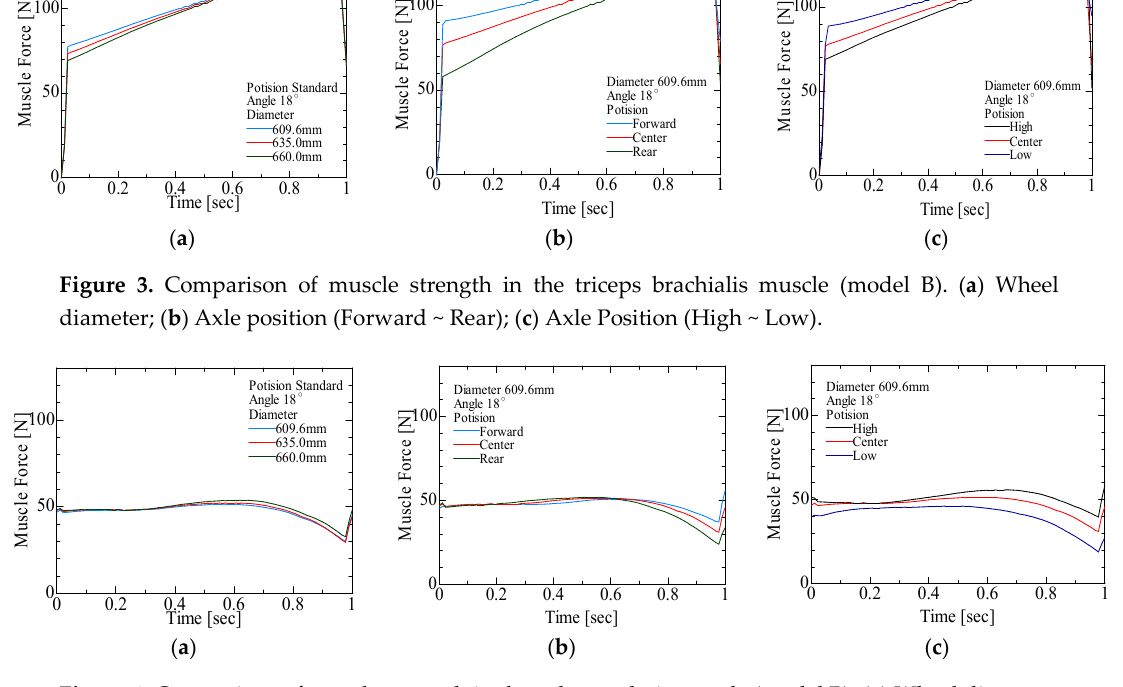
Figure 4. Comparison of muscle strength in the subscapularis muscle (model B). ( a ) Wheel diameter; ( b ) Axle position (Forward ~ Rear); ( c ) Axle Position (High ~